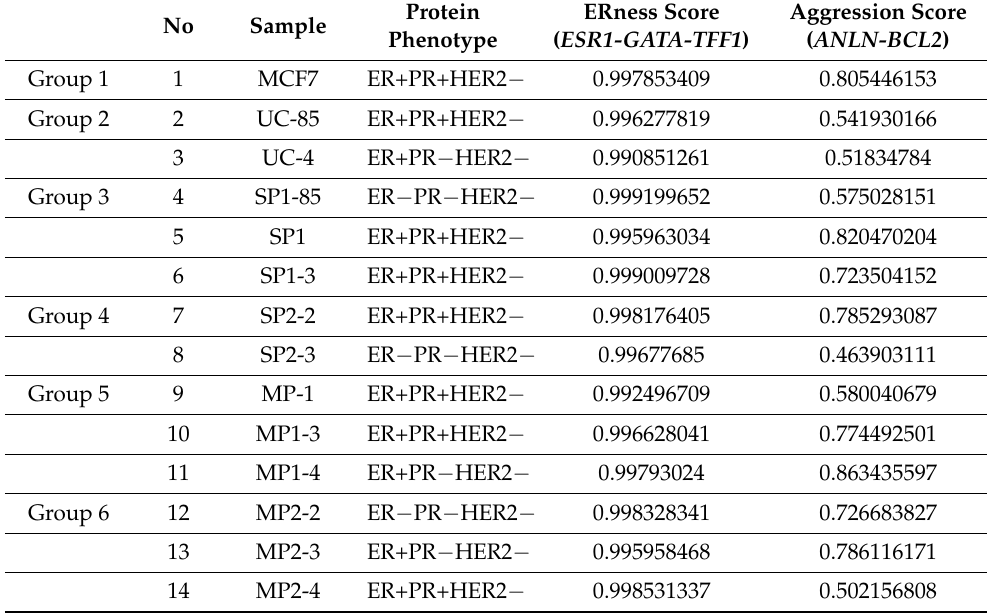
Table 2. Correlation of ER-IHC expression and ER transcript scores. Abbreviations: ANLN